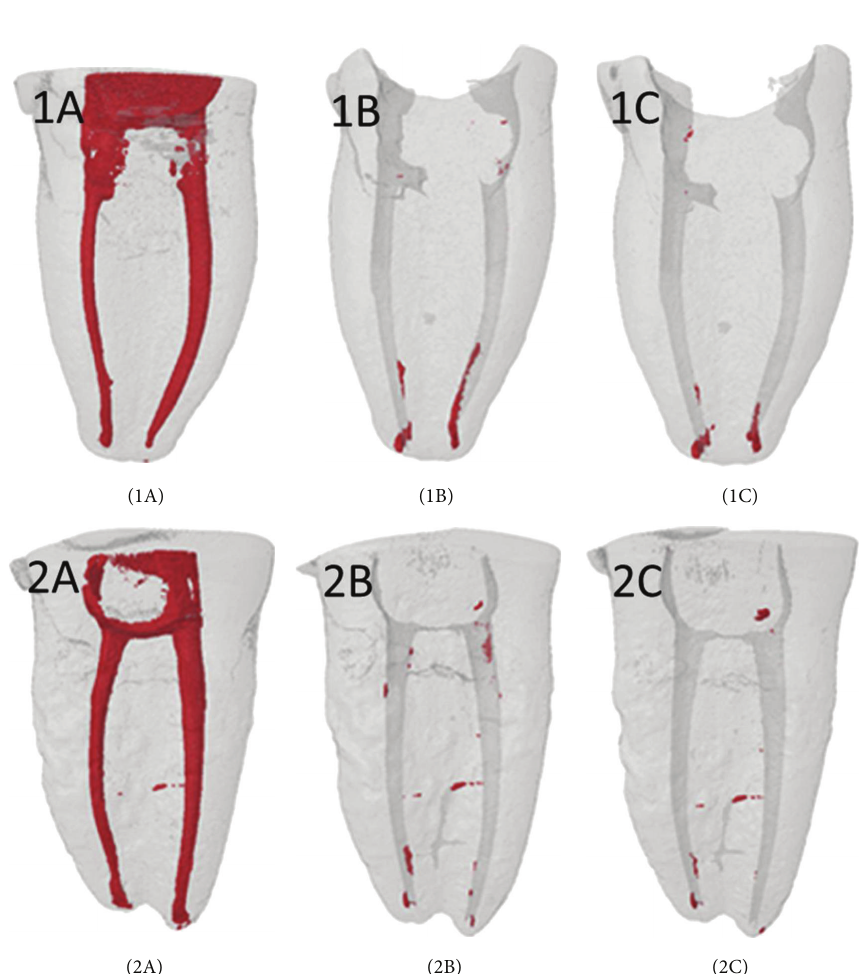
Figure 1: Representative cases of root filling removal. Canals instrumented with SAF (left canal) and Revo-S (right canal). After canal fillings with CLC (1A) and TT (2A) techniques. After reinstrumentation with D-RaCe (Step 1) (1B and 2B). After reinstrumentation with SAF (Step 2) (1C and